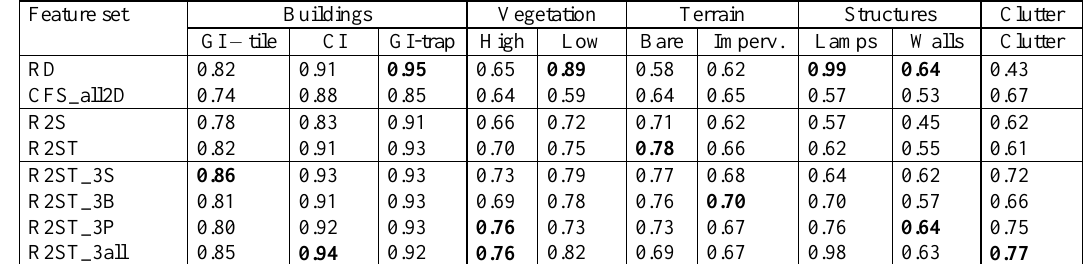
Table 8. Completeness of selected feature sets for the 10-class problem. (GI = galvanized iron, CI = corrugated iron, Imperv. =